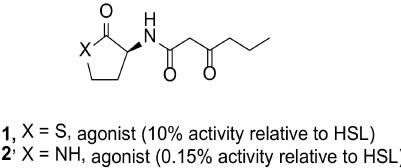
Figure 3. Thiolactone or lactam QS modulators in E. carotovora identified by Bycroft’s group. The general synthetic route to access thiolactone or lactam AHLs analogs is shown in Scheme 1. The synthesis is based on the coupling of the thiolactone or lactam scaffold with various carboxylic acids potentially bearing a protected 3-oxo group in the presence of EDC. Deprotection and eventual reduction by sodium cyanoborohydride afforded the corresponding 3-oxo and the 3-OH AHL analogs,